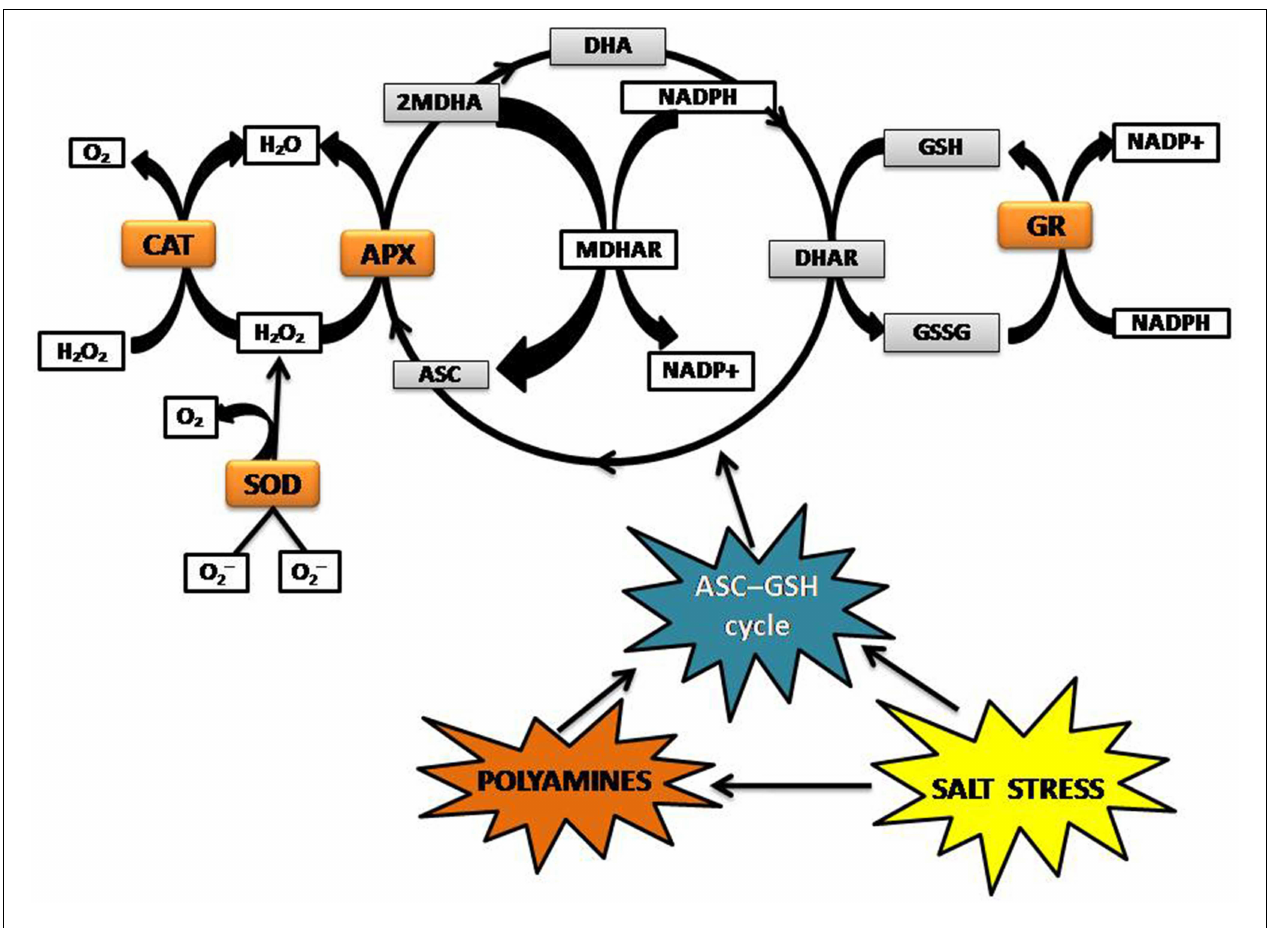
GSSG, glutathione disulphide; MDHA, Monodehydroascorbate; MDHAR, NAD(P)H-dependent oxido-reductase; SOD, Superoxide